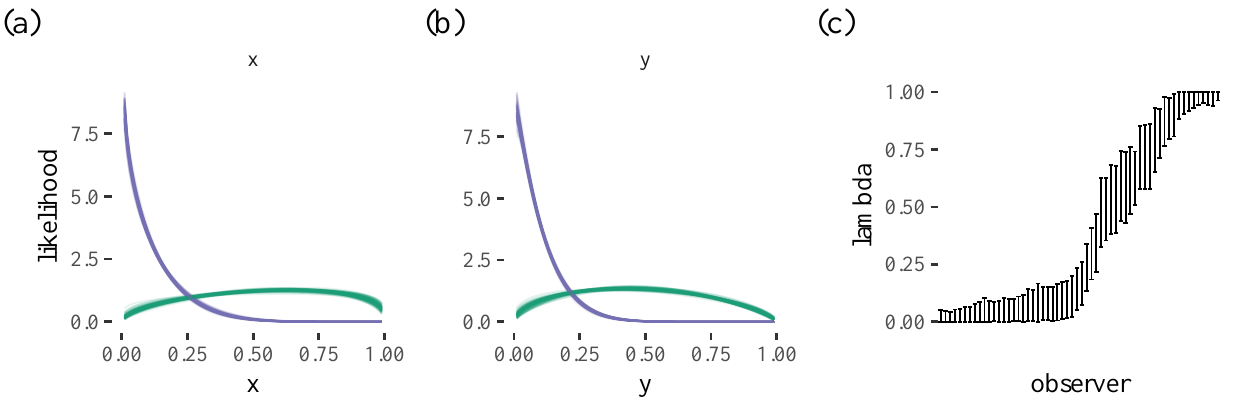
Figure 7. Posterior fits for the ( a ) horizontal and ( b ) vertical locations of the initial target selection. The two colours represent the two components in the mixture model. ( c ) shows the mixing parameters for each participant, with the error bar indicating the 95%